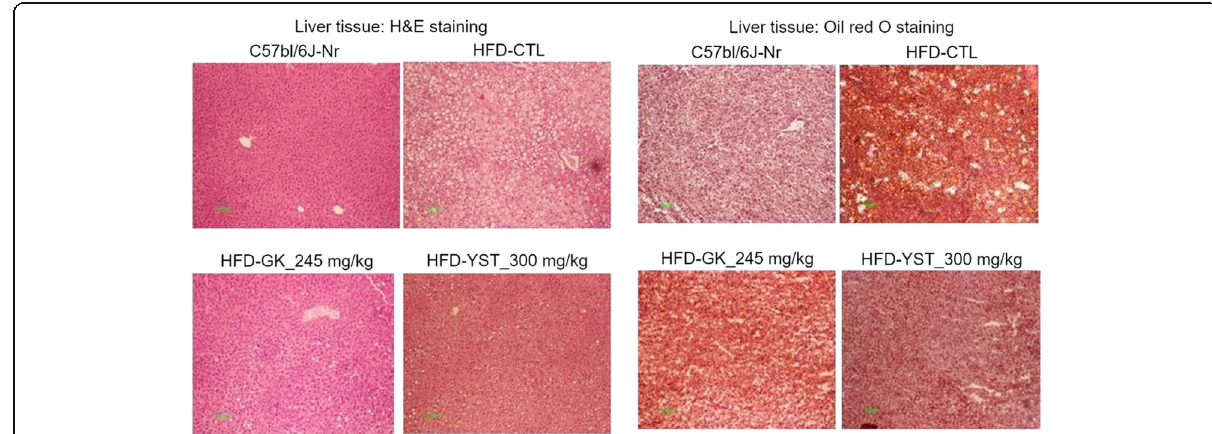
Fig. 5 Effect of YST extract on the histological profile of liver in mice that were fed a high-fat diet (HFD) are shown by H&E and Oil red O staining of the liver tissue sections of each group of mice. Normal diet group: C57bl/6 J-Nr; HFD-control group: HFD-CTL; HFD plus 245 mg/kg Garcinia cambogia extract: HFD-GK; HFD plus 300 mg/kg YST: HFD-YST